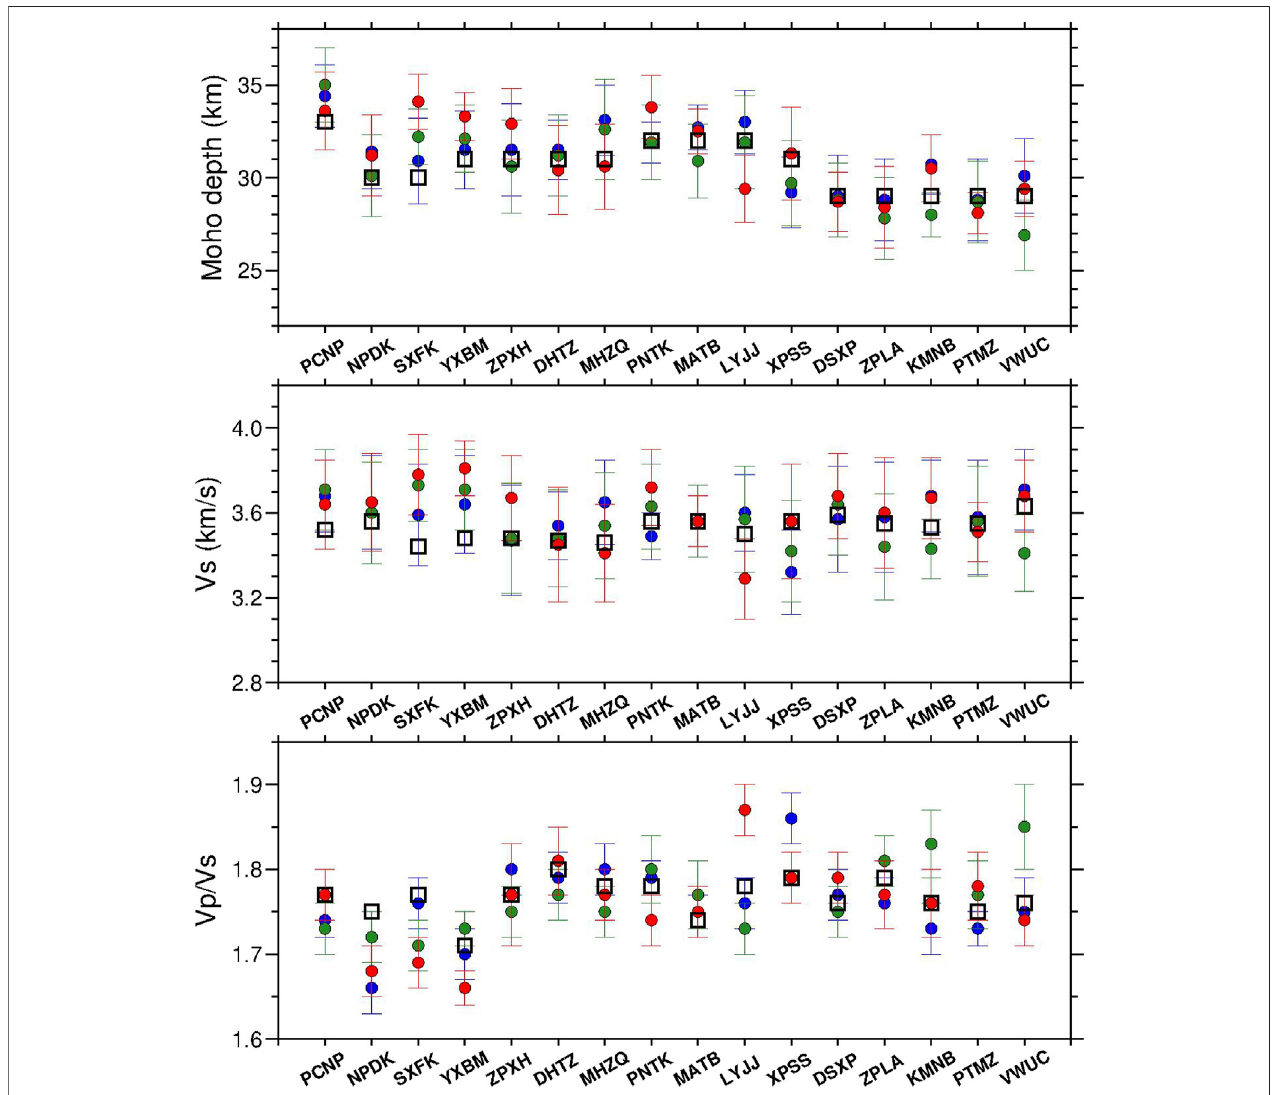
FIGURE 7 | Comparison of our results of the Moho depth, average crustal Vs, and Vp/Vs derived from the inversion models and H-V stacking for each station, arrangedaccording toits geologicalsetting inthe same order asthat in Figure 6 and Table 2 . Theopen black squares representthe results from theNAinversionwhile the red-, green-, and blue- fi lled circles show those from the H-V stacking method for the quadrants of NW, NE, and SE backazimuths, respectively.